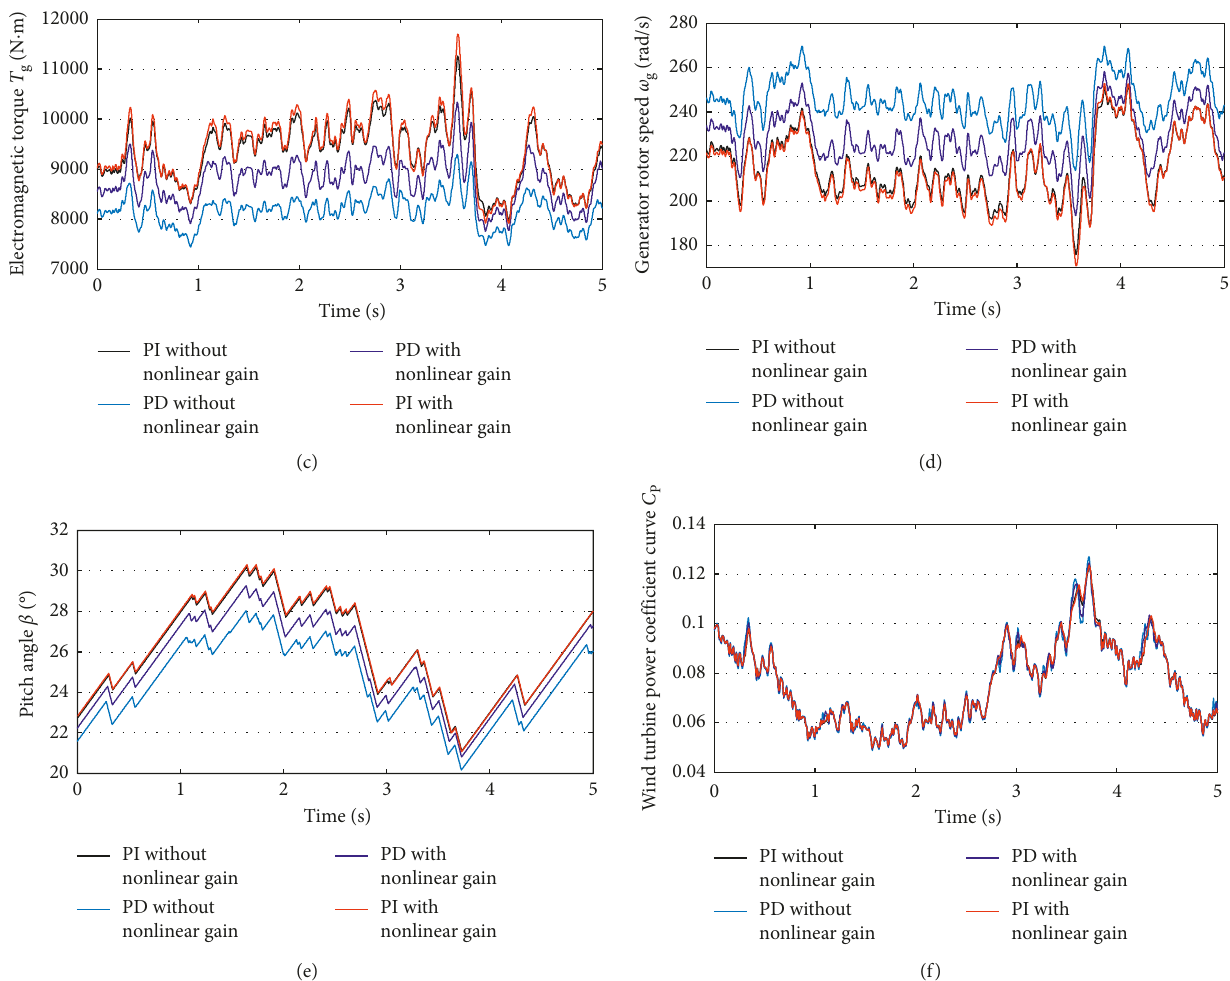
Figure 20: Responses under gradual change wind speed. (a) Wind speed curve. (b) Electromagnetic power curve. (c) Electromagnetic torque curve. (d) Generator rotor speed curve. (e) Pitch angle curve. (f) Wind turbine power coefficient